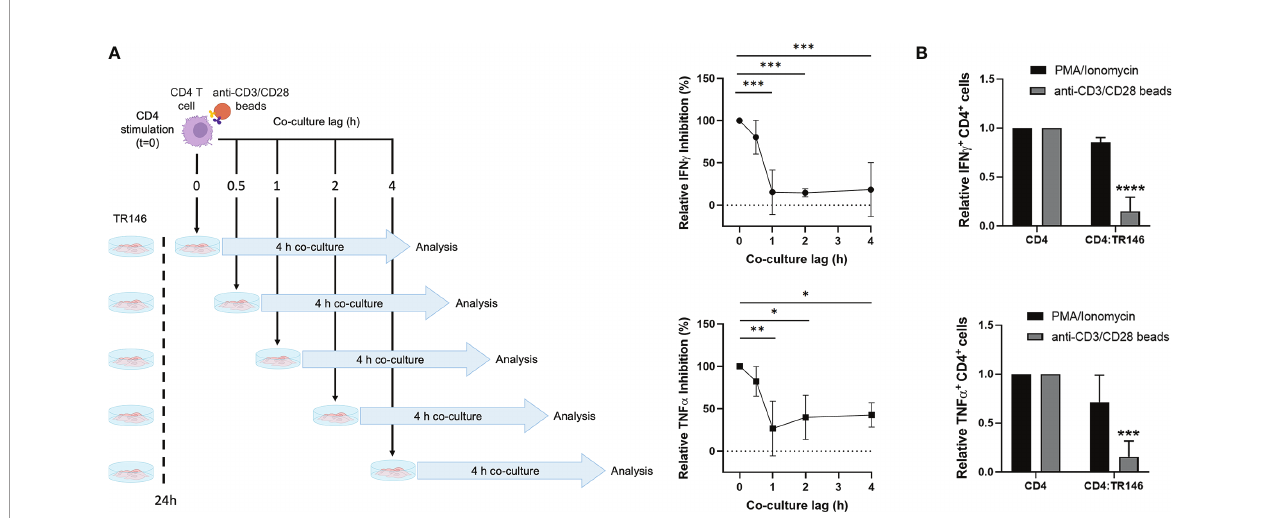
FIGURE 2 | CD4 T cell inhibition by TR146 cells takes place early during TCR signaling. (A) CD4 T cells were incubated with anti-CD3/CD28 antibodies for different times (0, 0.5, 1 or 2 hours) before an additional 4-hour co-culture with TR146 cells. Activated CD4 T cells were also cultured alone. Schematic diagram on the left depicts the experiment work fl ow. The percentage of CD4 T cells that were inhibited when cultured with TR146 cells in comparison to CD4 T cells cultured alone for each co-culture lag time were detected by fl ow cytometry. Data are expressed as the percentage of IFN g and TNF a inhibition relative to control of maximum inhibition (co-culture lag time = 0 h). (B) CD4 T cells were activated with PMA/ionomycin or anti-CD3/CD28 beads and cultured alone or with TR146 cells for 4 hours. The amount of IFN g and TNF a -producing CD4 T cells was measured by fl ow cytometry and expressed as relative to control. FACS gatings were adjusted by the use of mouse anti-IgG-PE and anti-IgG-APC antibodies. All data are plotted as mean values with error bars corresponding to SEM. Statistically signi fi cant differences were obtained applying ANOVA tests. Signi fi cant differences (p < 0.05, p < 0.01, p < 0.001 and p < 0.0001) are noted as “ * ” , “ ** ” , “ *** ” and “ **** ” , respectively. Data were obtained from a total of three independent experiments using samples from different